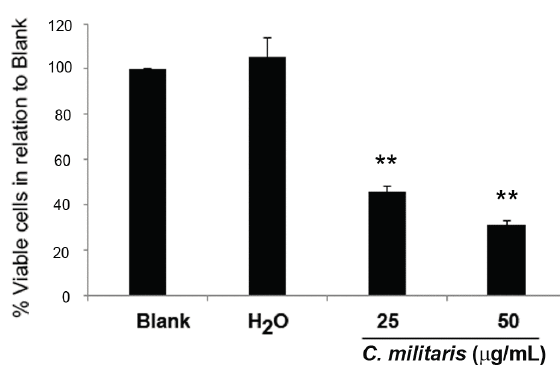
Figure 1. Effect of C. militaris methanolic fruiting body extract on NCI-H460 cell viability. Viable cell number was analyzed 48 h after incubation with complete medium (Blank), 25 μ g/mL or 50 μ g/mL extract or with the highest vehicle concentration (H 2 O). Results are presented as a percentage of viable cells in relation to blank cells and are the mean ± SEM of six independent experiments. ** p ≤ 0.001 blank vs.